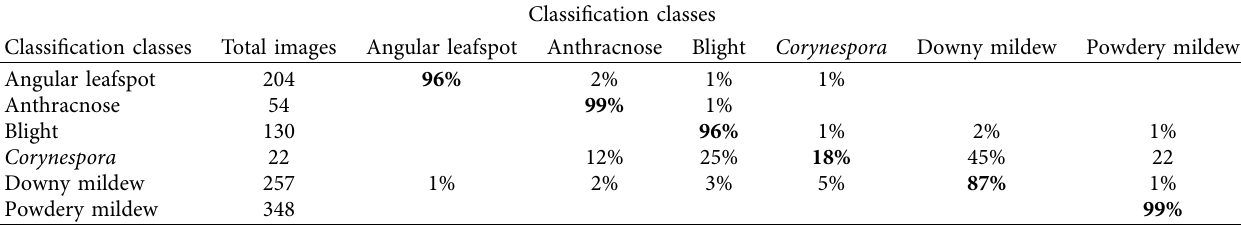
Table 6: Confusion matrix of cucumber leaf dataset of test 1 on